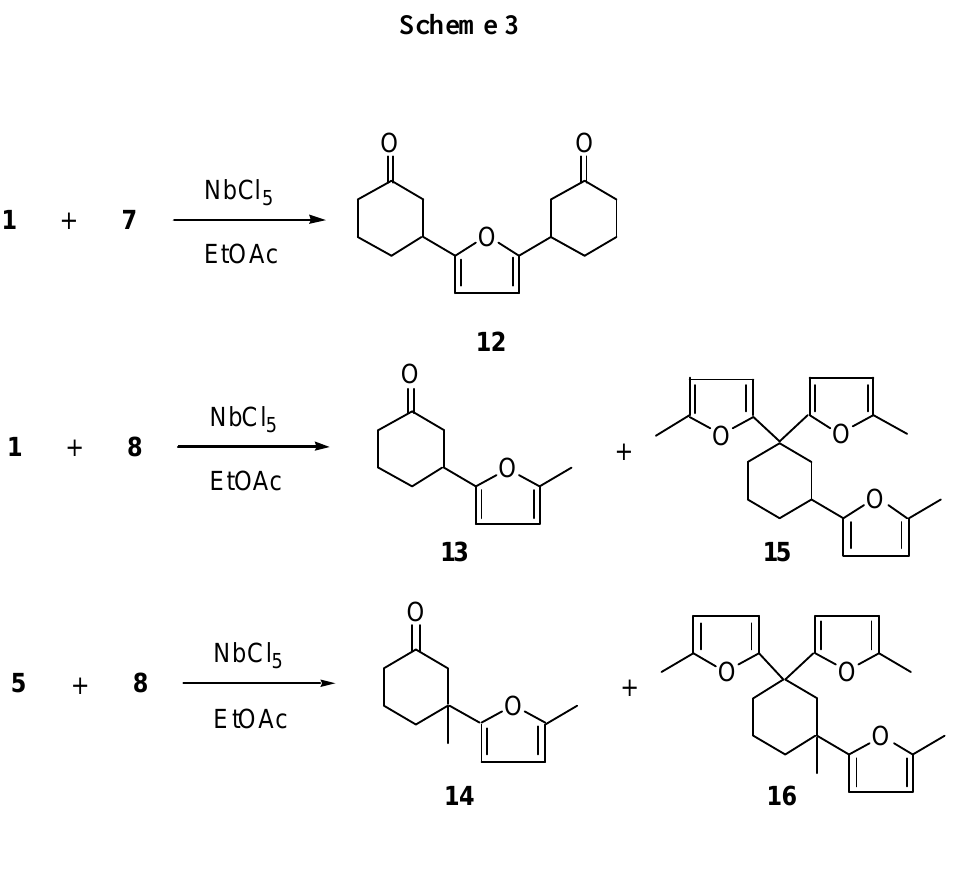
Table 2. Results of reaction of enones 2 - 5 with NbCl